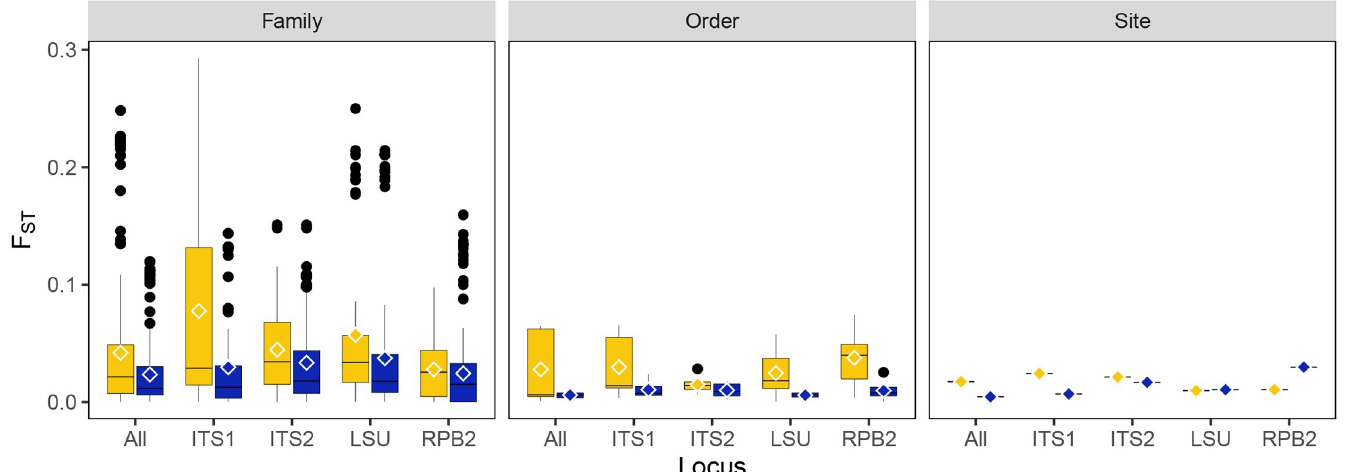
Fig 5. F ST calculations for each locus and all four combined. F ST calculated between host order, host family, and collection site (syn. population). Yellow–all data, blue–clone corrected data. Mean F ST is illustrated by an open